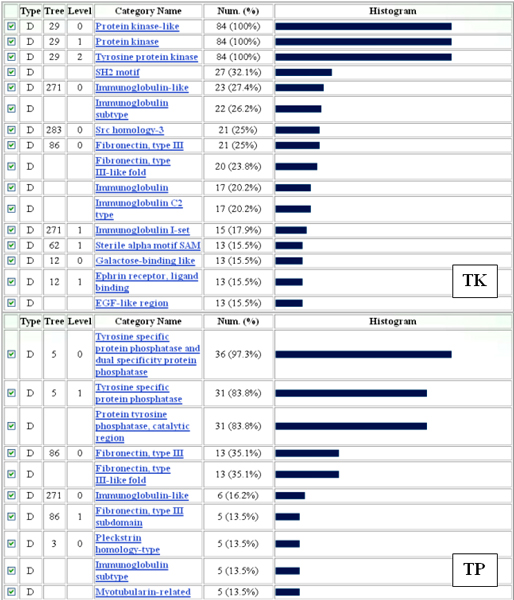
GFINDer Exploration Protein Familes&Domains module: protein domain exploration. InterPro protein domains related to the considered tyrosine kinase (TK) or tyrosine phosphatase (TP) gene classes; Type: type of InterPro entry (D: protein domain); Tree: tree label in the defined protein domain parent/child hierarchy, if any; Level: level in the related tree of the defined protein domain parent/child hierarchy, if any (higher levels correspond to more specific protein domains); Num. (%): absolute and percentage number of considered genes that codify proteins containing the specific protein domain (Category Name).